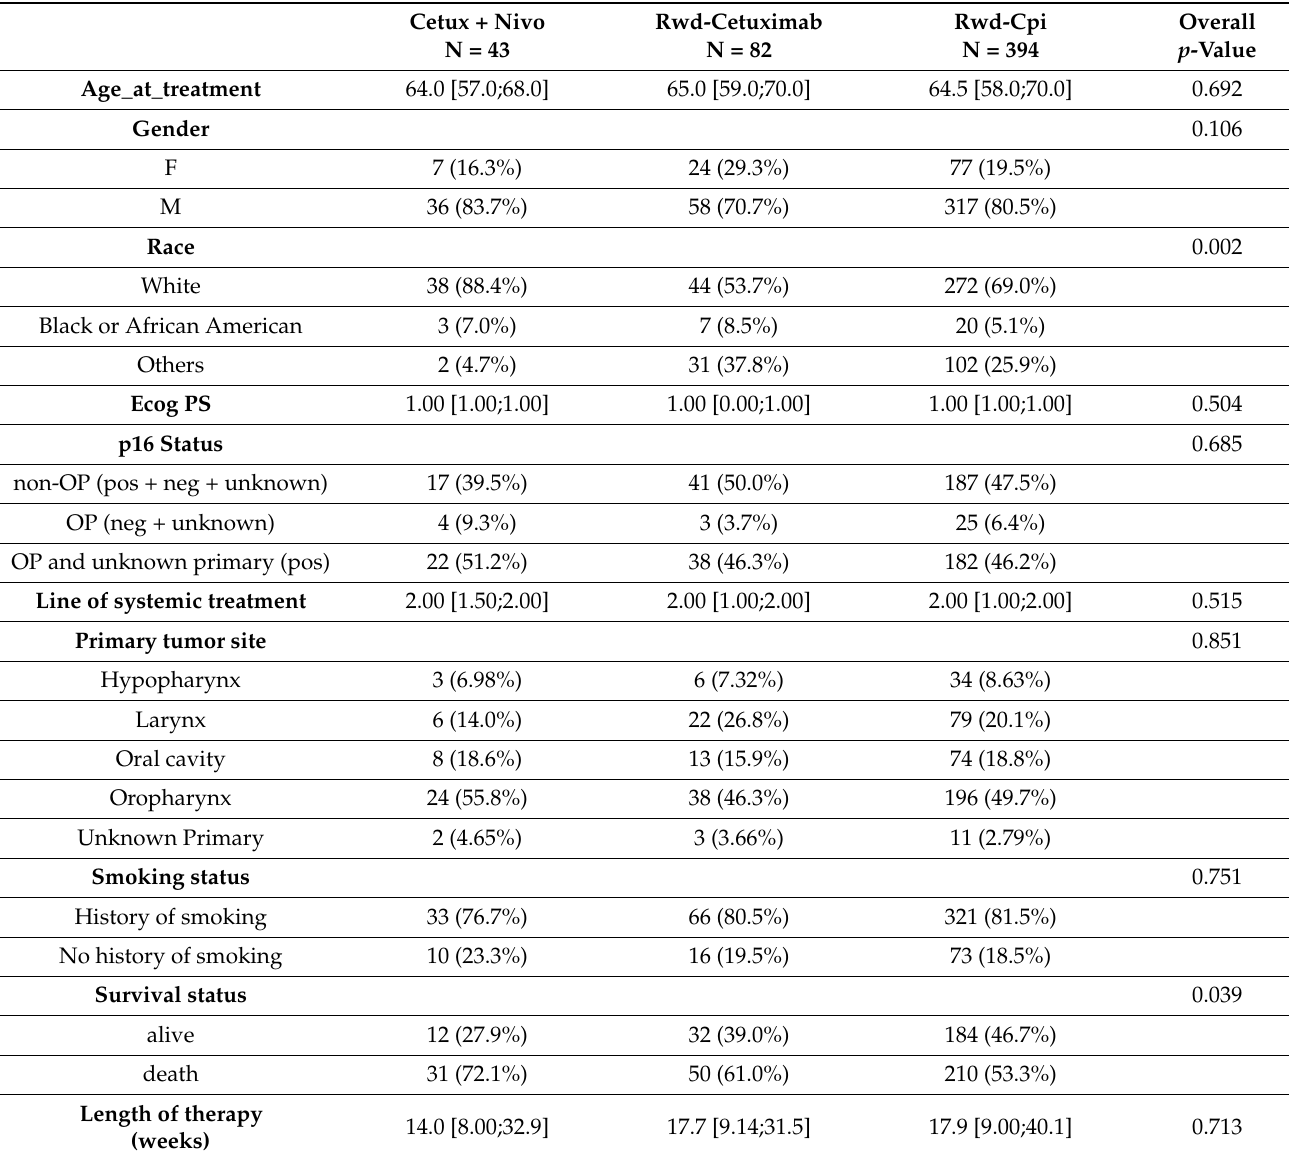
Table 4. Patient characteristics after propensity score